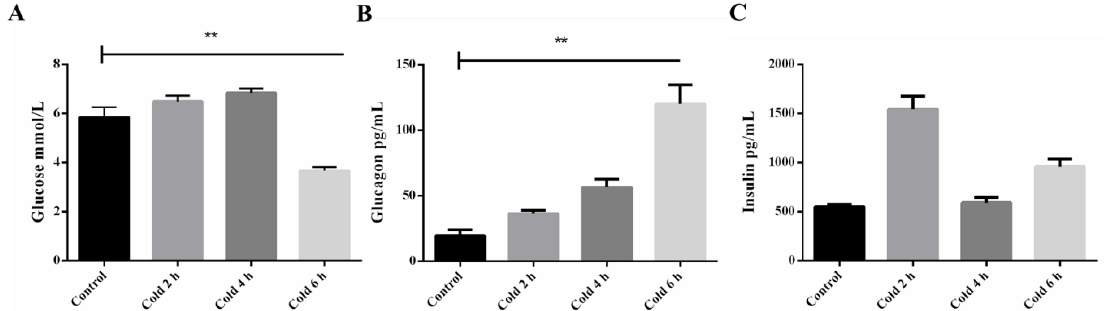
Figure 1. Effect of acute cold stress on the levels of ( A ) plasma glucose, ( B ) glucagon, and ( C ) insulin in the liver. ( A ) The data are presented as mean ± standard error of the mean (SEM) ( n = 8). Statistically significant differences are indicated, ** p < 0.01.